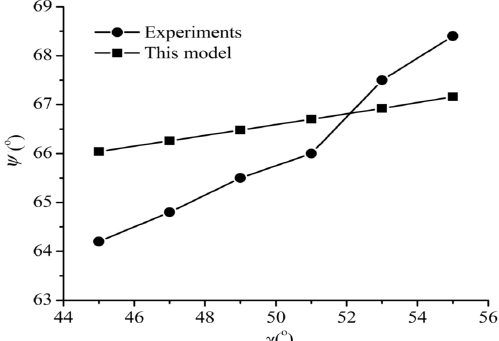
Figure 5: Geometric feature parameters of rock fragment. Figure 6: Vertical fracture angle of experiments and theoretical